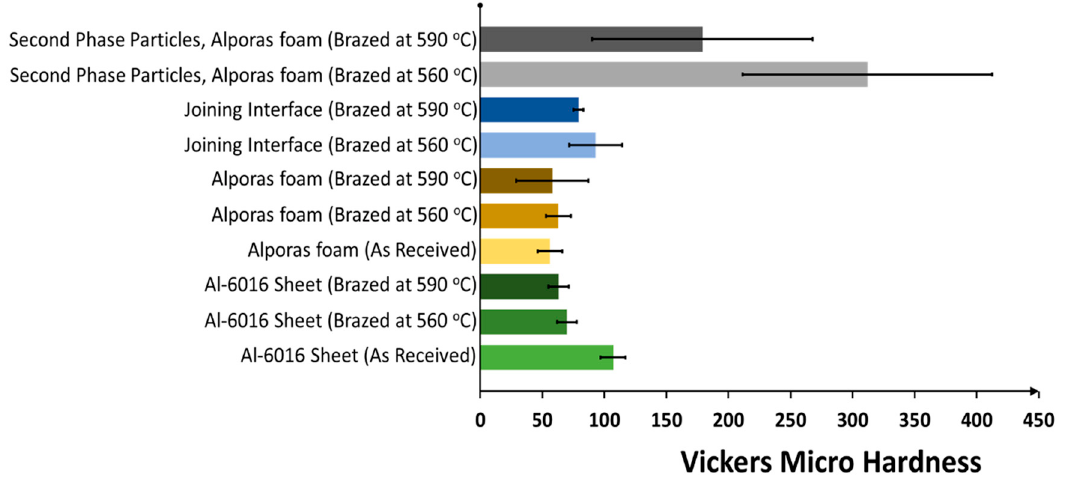
Figure 8. Average microhardness analysis results.